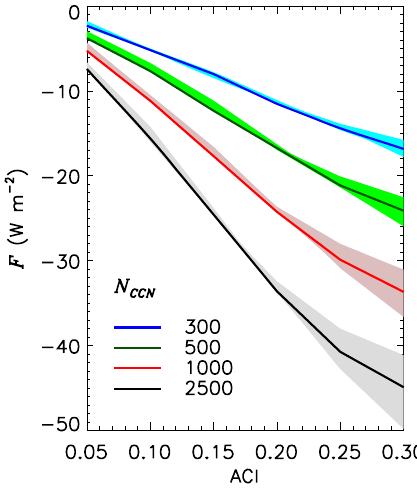
Fig. 2. The amount of forcing as ACI τ varies across the observed range in Fig. 1b.Values for forcing are given for the difference of four different N CCN concentrations from N CCN = 100cm − 3 and the shaded envelopes represent the range of forcing for each of these concentrations for a range of L from 50–200gm − 2